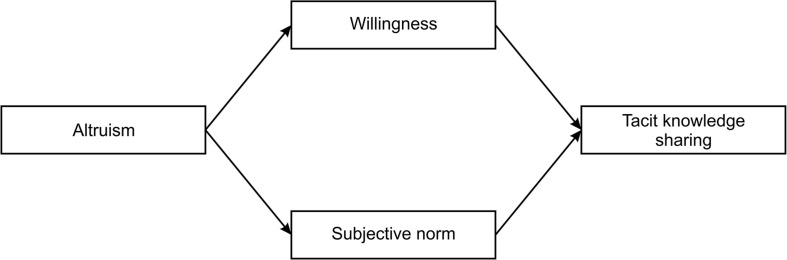
Research model of the study.